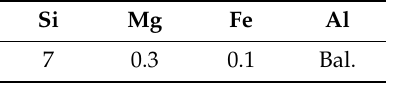
Table 1. Chemical composition of original Al-Si powder (wt %).